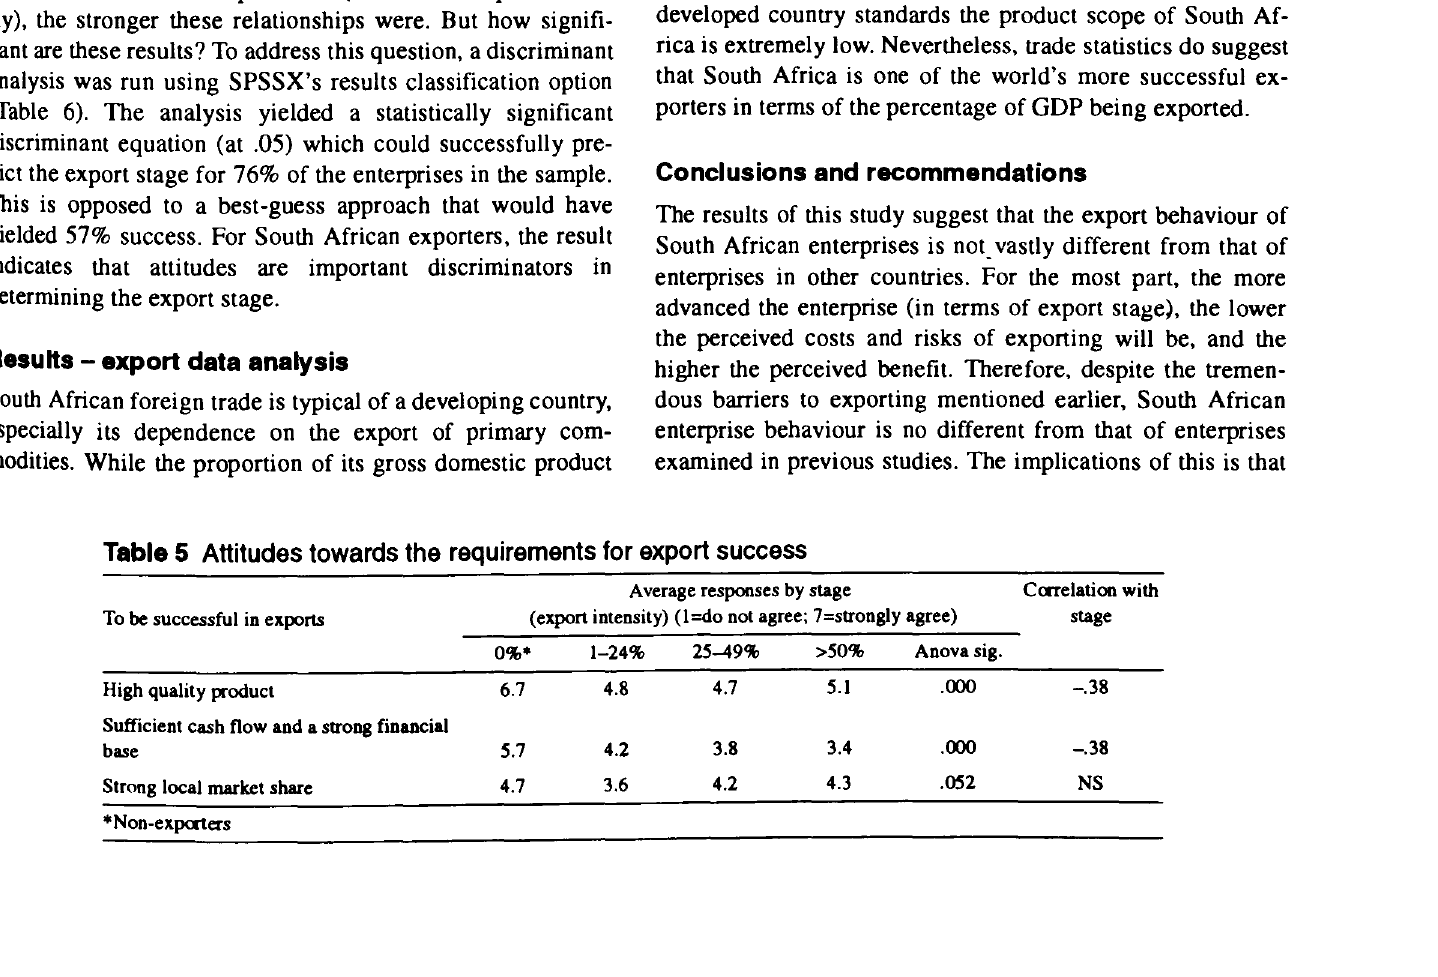
Table 5 Attitudes towards the requirements for export success To be successful in exports High quality